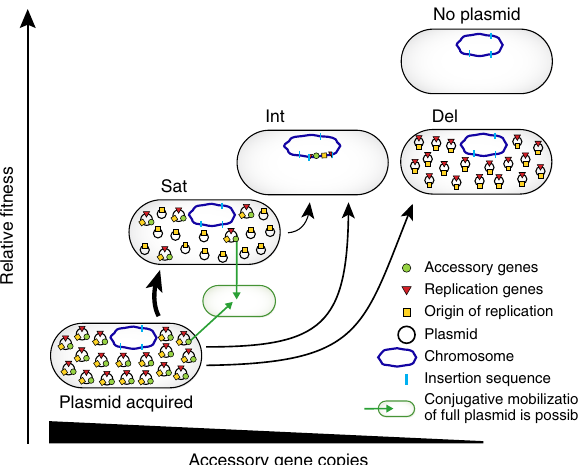
Fig. 5 Evolutionary pathways after plasmid acquisition. This model